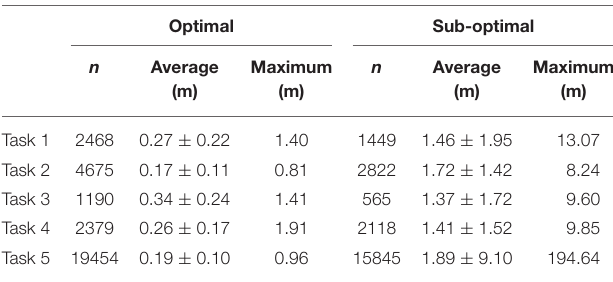
TABLE 1 | Difference between the LPS and reference system for position, for optimal and sub-optimal condition